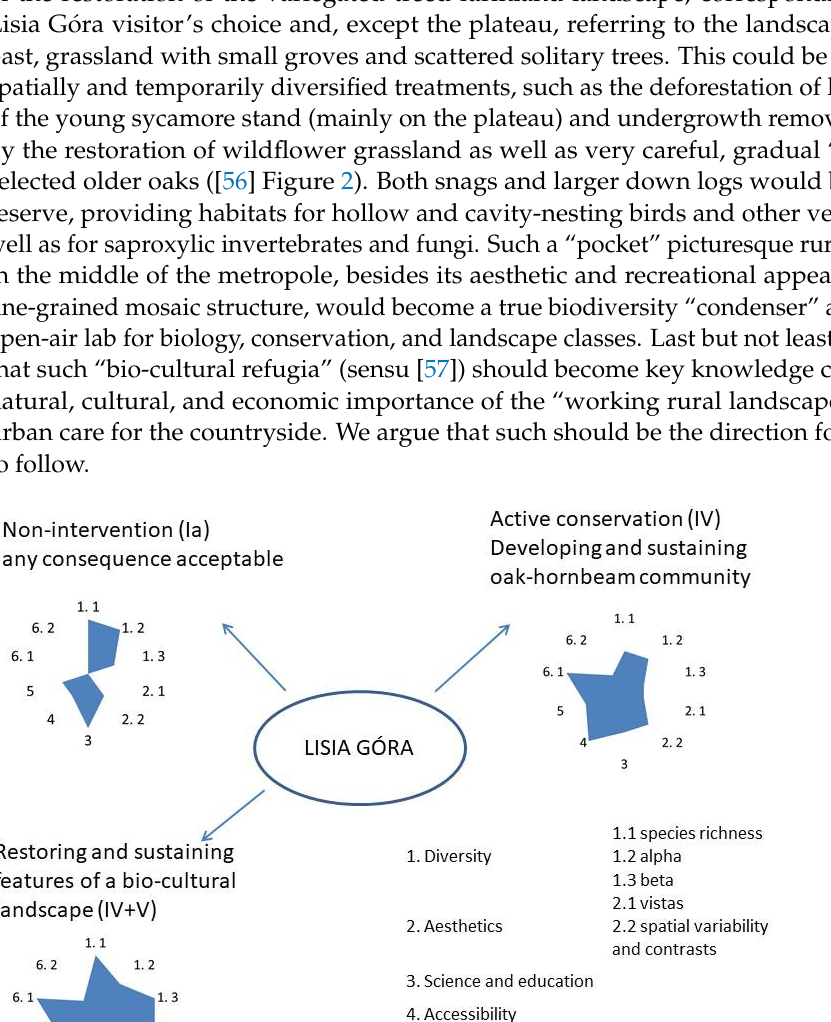
Table S1: List of plant species with selected traits, Form S1: Survey questionnaire form (English